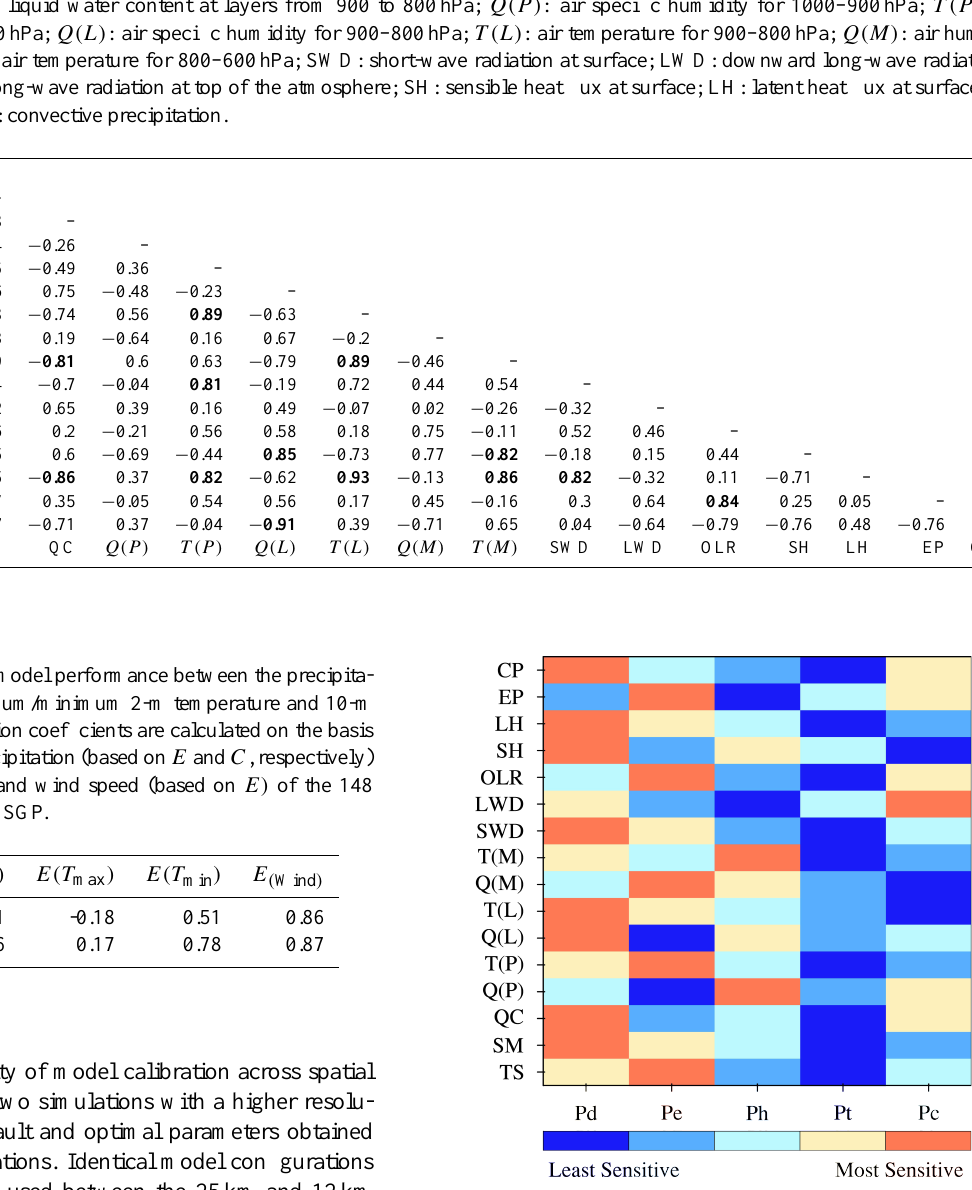
Table 3. Correlations among different model output variables in 148 WRF simulations (25-km, SGP) with perturbed parameters in the KF scheme. The correlation coefficients are calculated based on the domain average as shown in Fig. 3. TS: skin temperature; SM: soil moisture; QC: cloud liquid water content at layers from 900 to 800hPa; Q(P) : air specific humidity for 1000–900hPa; T (P) : air temperature for 1000–900hPa; Q(L) : air specific humidity for 900–800hPa; T (L) : air temperature for 900–800hPa; Q(M) : air humidity